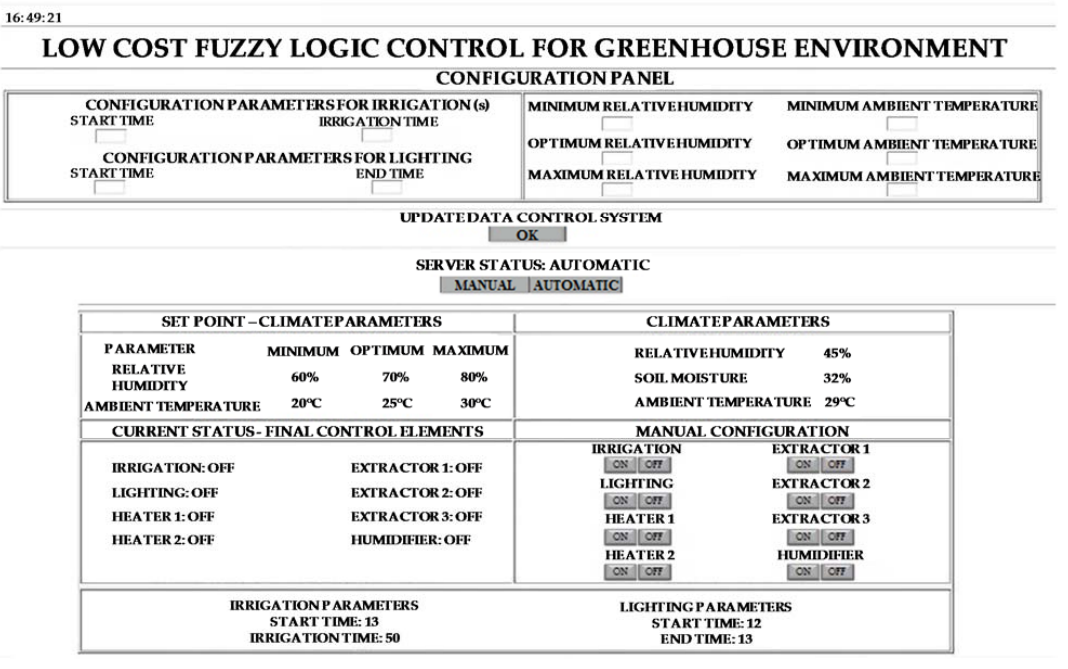
Figure 7. Web interface.